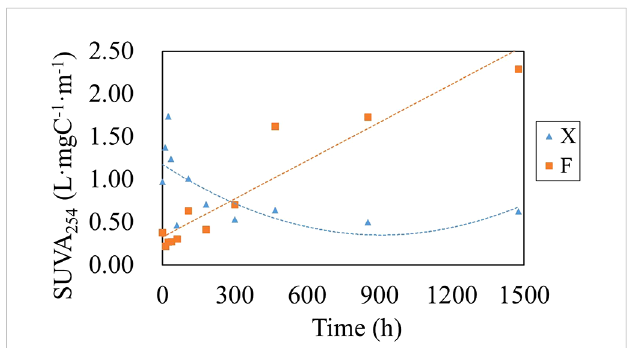
FIGURE 9 RDA of the microbial component at the genus level and water chemical